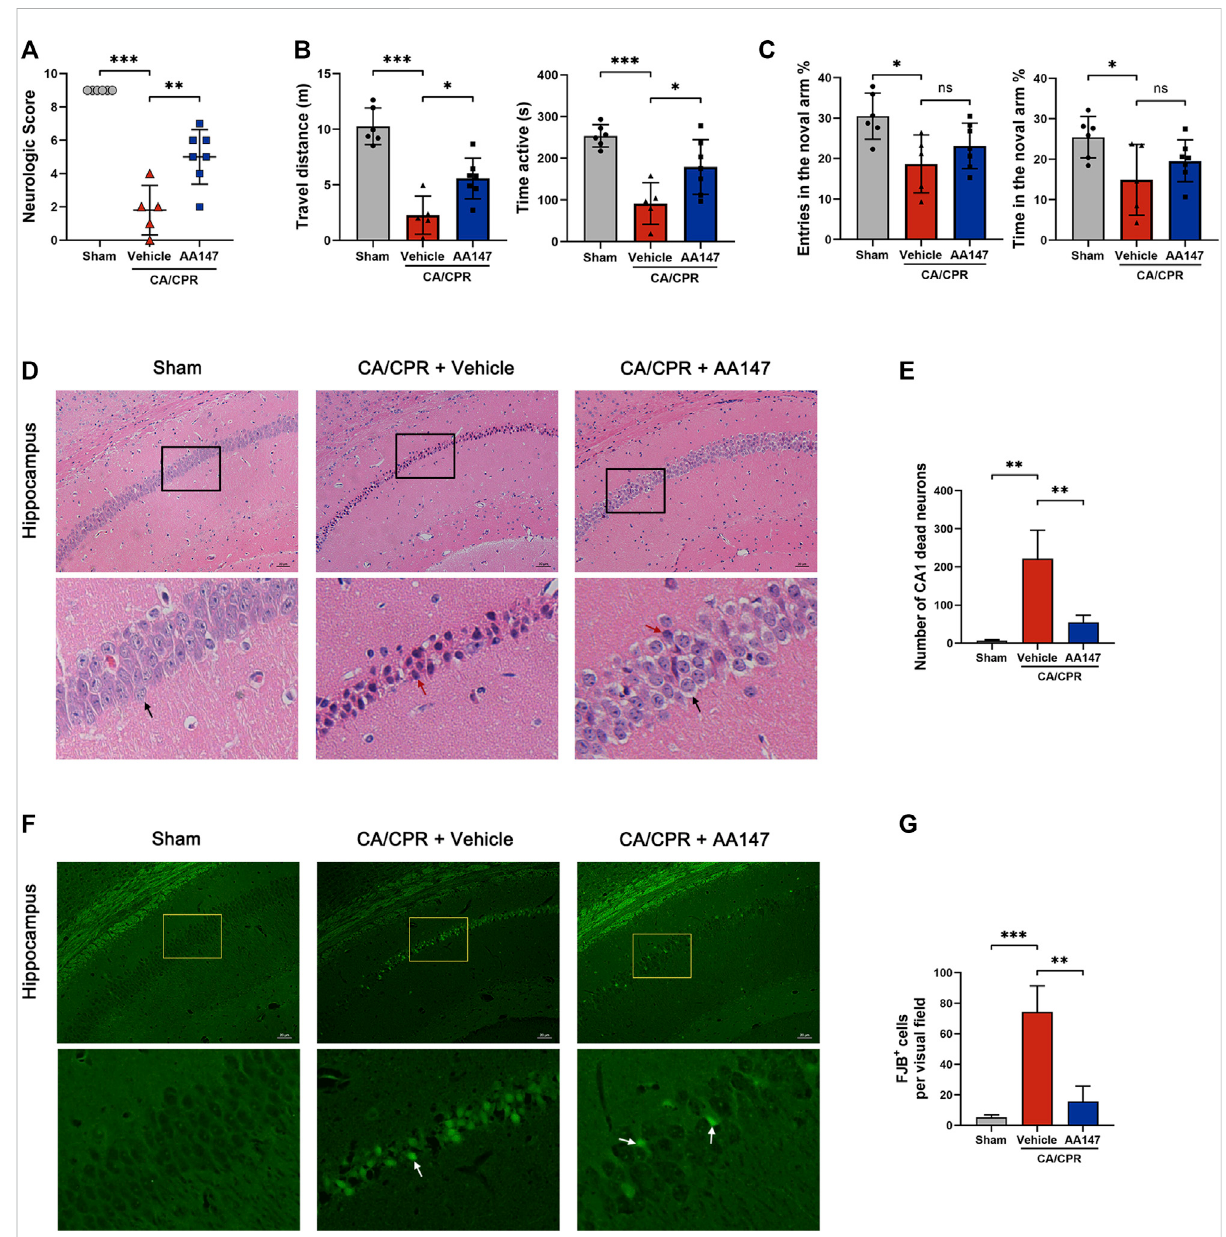
FIGURE 2 AA147 improved neurological outcomes and decreased neuronal death post-cardiac arrest and cardiopulmonary resuscitation (CA/CPR). Mice were subjected to sham or CA/CPR surgery, with vehicle or AA147 administered 1 day before thesurgery and 15 min after the returnof spontaneous circulation (ROSC). The effect of AA147 on improving neurological function and reducing neuronal death was evaluated at 3 day after CA/CPR. AA147-treated mice scored signi fi cantly higher in the neurologic scoring system: the 9-point scoring system (vertical screen, horizontal bar, and rope) (A) , and had longer travel distance and active time in the open fi eld test (B) . However, there was no signi fi cant difference in the improvement of cognitive function between group CA + Vehicle and CA + AA147, presented in Y-maze. (C) Data are presented as mean ± SD ( n = 5 – 7). (D) Representative HE staining images of the hippocampal cornu ammonis 1 (CA1) region and (E) counts of dead CA1 neurons. Black arrows indicate the normal pyramidal cells with intact morphology, while red arrows show the dead neurons with shrunken pro fi les and pyknotic and deeply-stained nuclei. Scare bar = 20 μ m. Data are displayed as mean ± SD (n = 3). (F) Representative images of FJB staining and (G) the number of FJB + neurons in the hippocampal CA1 region of each group. White arrows show the FJB + neurons stained with green fl uorescence, indicating neuronal death. Scare bar = 20 μ m. Data are displayed as mean ± SD ( n = 3). * p < 0.05. ** p < 0.01. *** p <